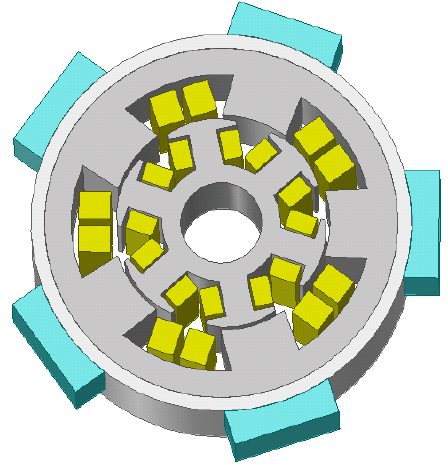
Figure 1. Single phase modular configuration.